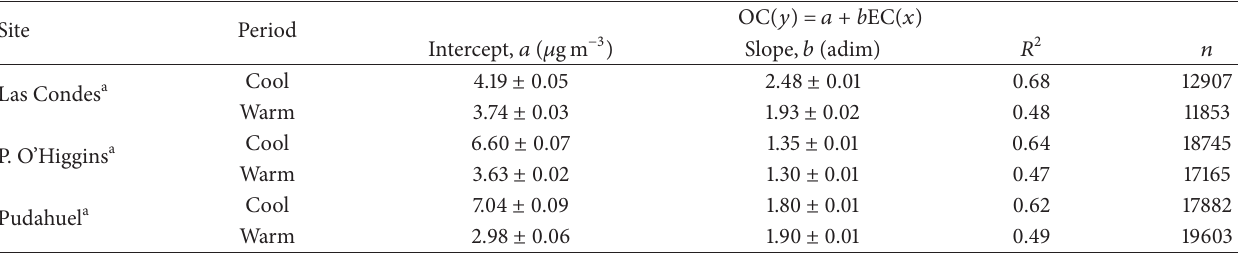
Table 4: OC versus EC linear correlation in PM 2.5 for the stations studied in the period from 2002 to 2007. 𝑎 is the slope, 𝑏 (adim) is the intercept ( 𝜇 g/m 3 ), 𝑅 2 is the square of the correlation coefficient, and 𝑛 is the number of data